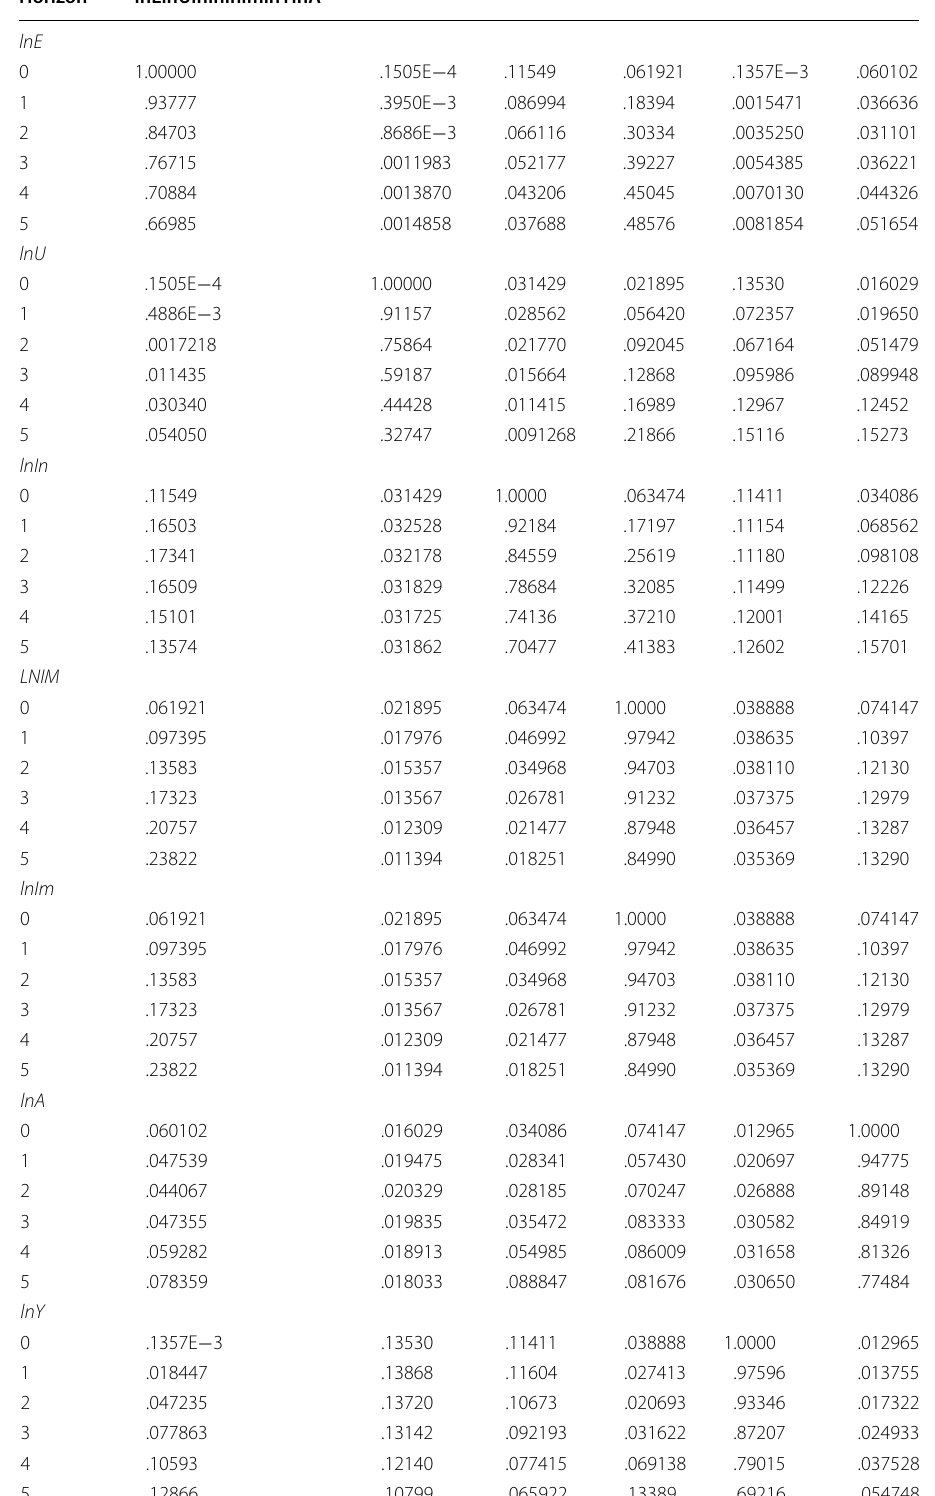
Table 7 Generalized forecast error variance decomposition for variable